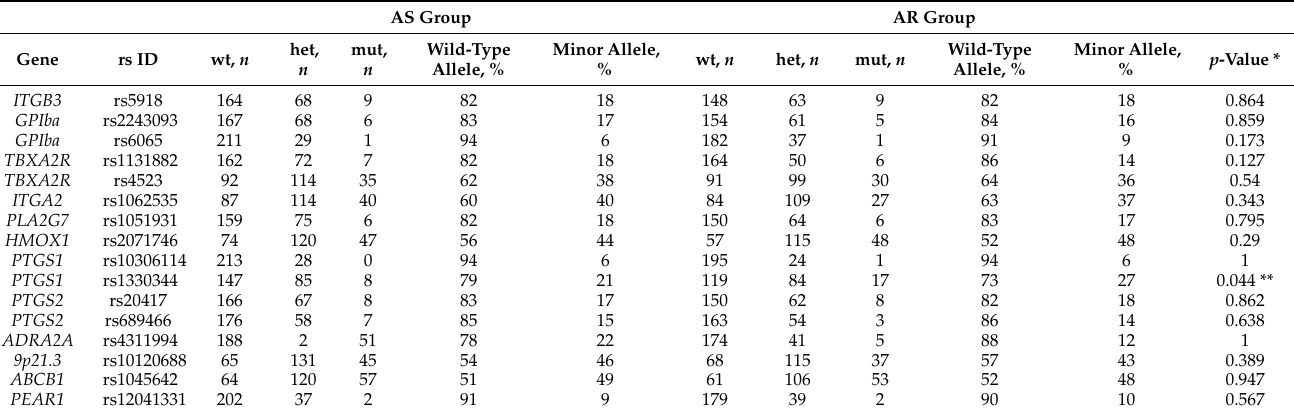
Table 3. Genotype and allele frequencies in the AS and AR